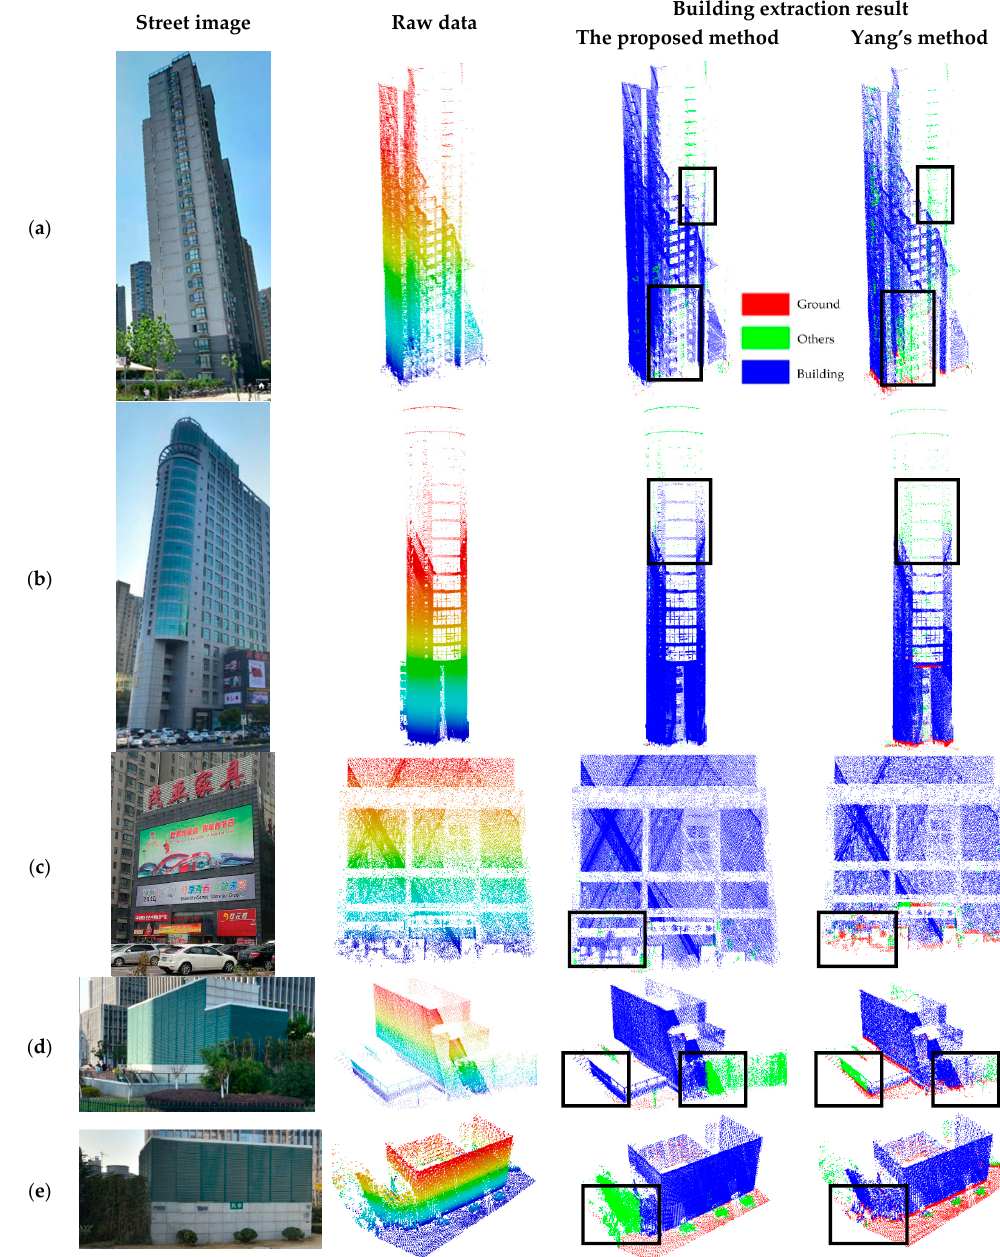
Figure 12. Comparison of building extraction result between the proposed method and the method of Yang et al. [37]. ( a – e ) Left to right: street image, raw VLS data, the result by the proposed method and the result by Yang’s method of the specific building.